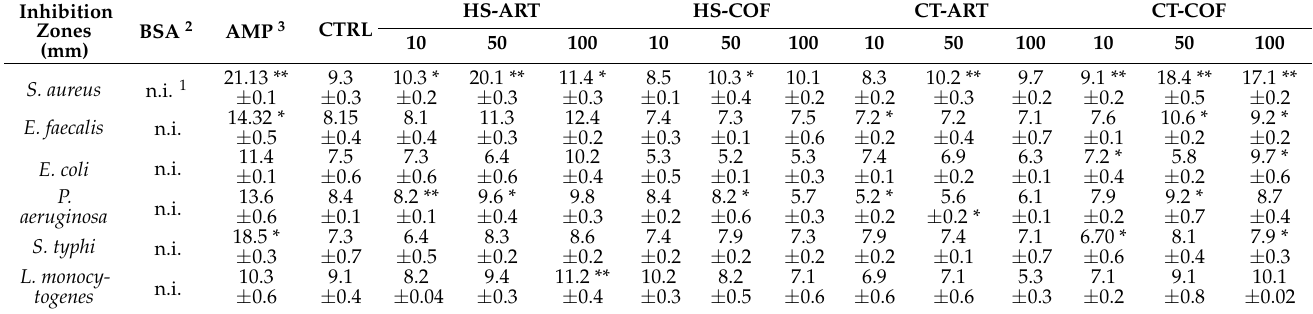
Table 2. Inhibition zones (mm) of methanolic extracts from basil plants treated with humic substances or compost teas from artichoke or coffee grounds residues (HS-ART; HS-COF; CT-ART; CT-COF) at three different concentrations (10, 50, 100 mg L − 1 ) against S. aureus , E. faecalis , E. coli ,